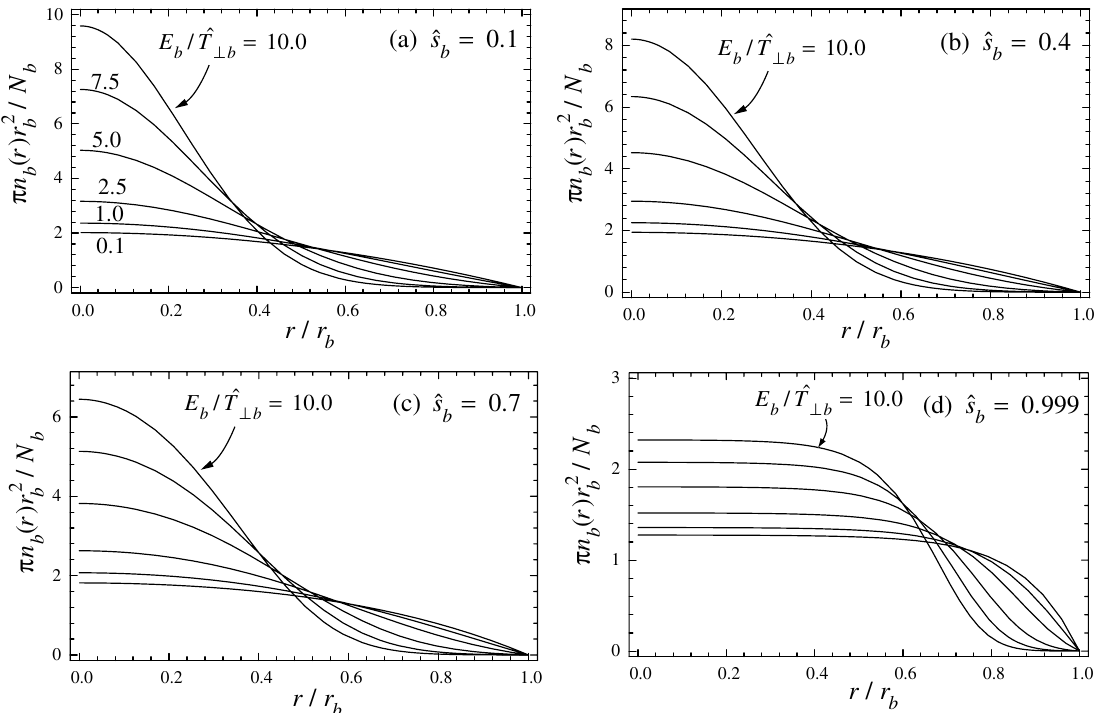
(cid:1) r (cid:3) (cid:25)r 2 =N versus r=r obtained from Eqs. (6) and (8) for (a) ^ ss b b b b = ^ TT )=) identical to those in Fig. ? b and b 0